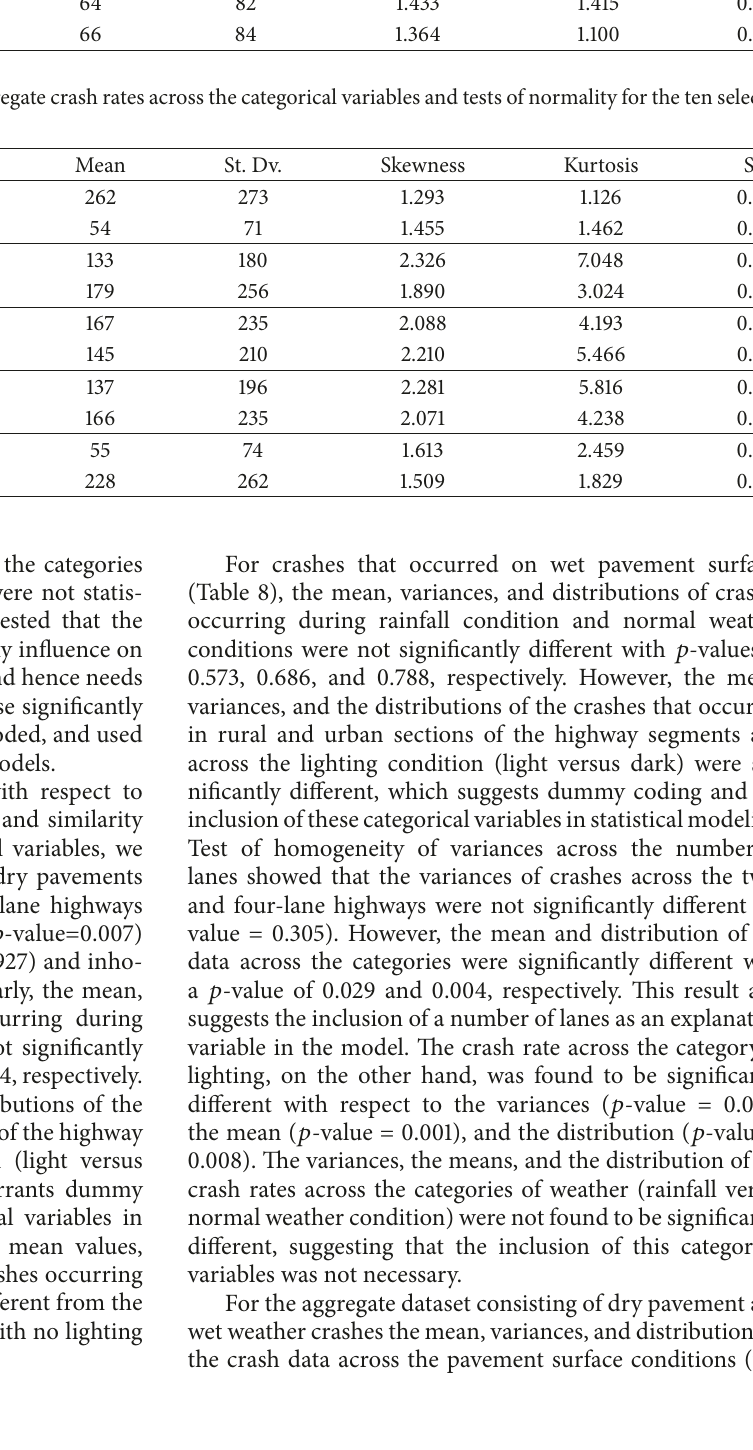
Table 6: Descriptive statistics of the nonsevere aggregate crash rates across the categorical variables and tests of normality for the ten selected routes.